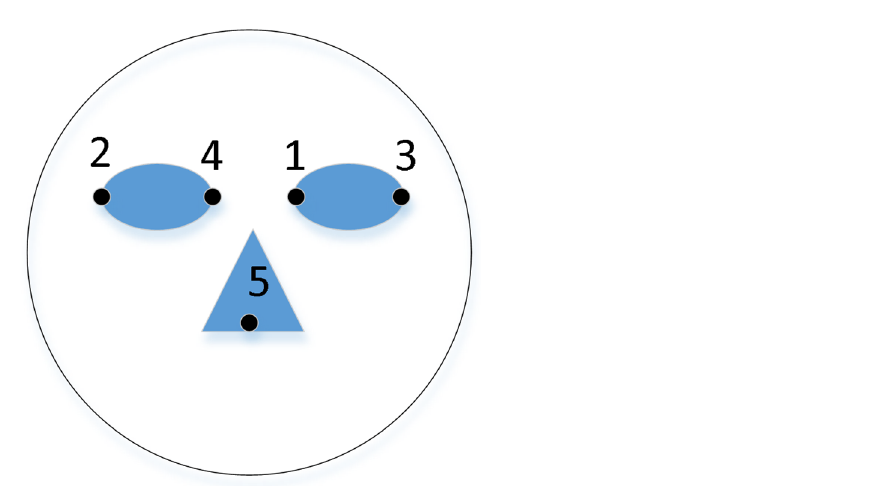
7 of 15 Figure 4. Flowchart of the modified ICP algorithm used in this investigation.